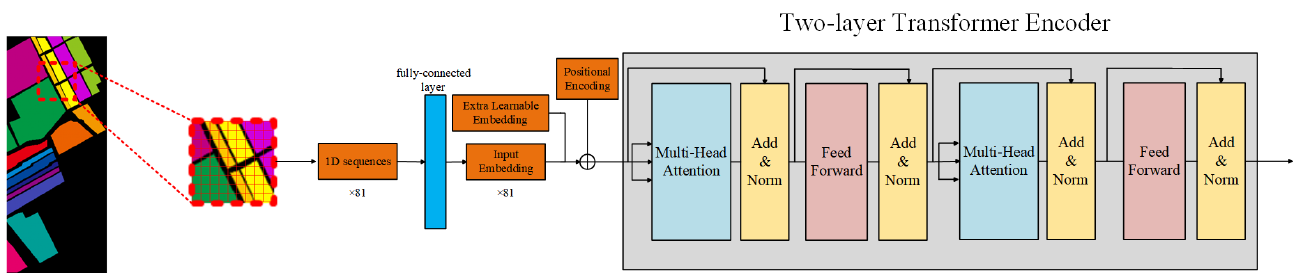
Figure 2. The structure of the transformer model used in the experiments. We used a two-layer transformer. The input was 27 × 27 × band . Then, the input image was split into 3 × 3 × band patches and reshaped into 1D sequences. Next, we obtained the embedding of each sequence via a fully connected layer. Finally, we fed the embeddings to the transformer model after adding the position embeddings to the patch embeddings and an extra learnable